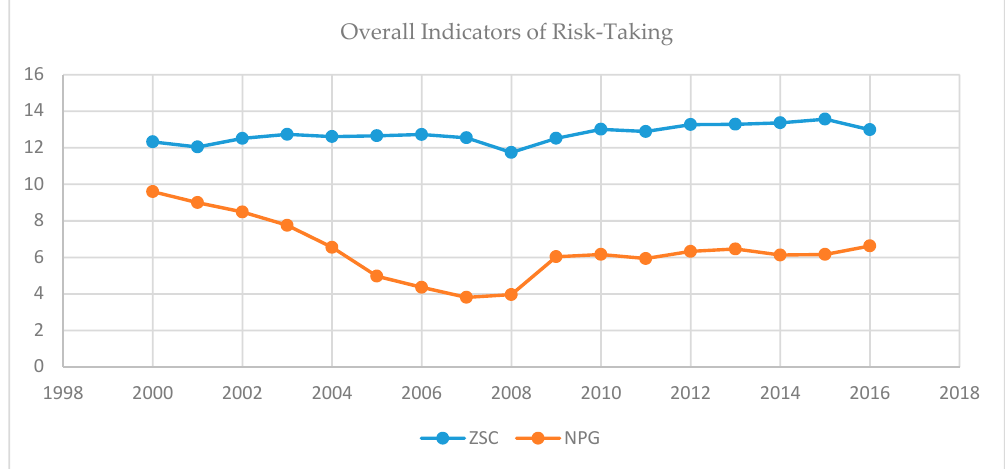
Figure 2. Overall level of financial stability across the globe. Across the globe the banking system is different experienced from 2000 to 2016. Both of the indicators are the risk-taking behavior (Z-score and non-performing loans to gross loans ) Source: Author’s calculation, World Bank, (GFDD).